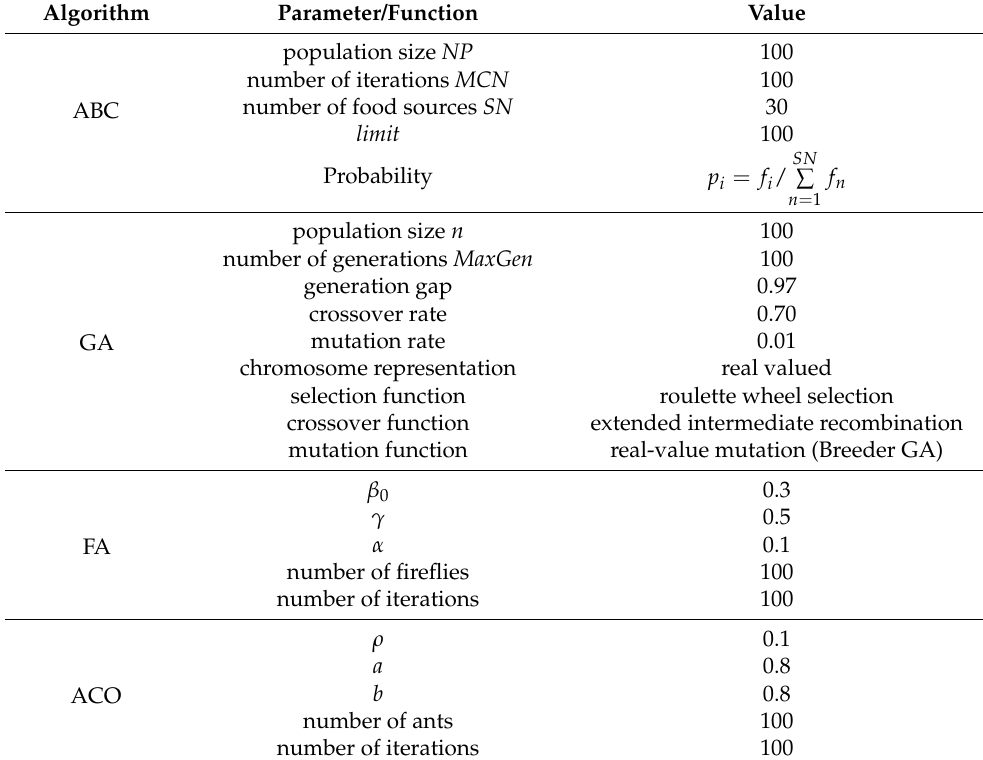
Table 2. Parameters setting of